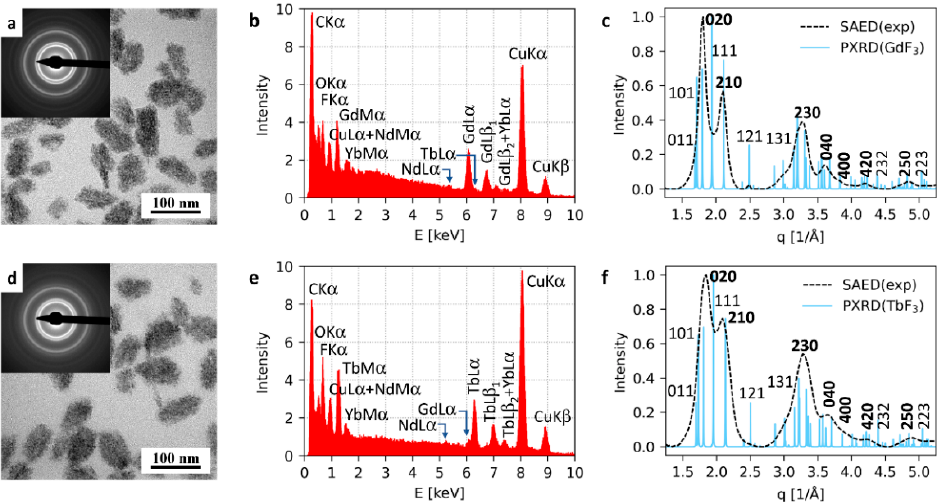
Figure 4. Characterization of P(DMA-AGME)-Ale-coated ( a – c ) GdF 3 :Tb 3+ ,Yb 3+ ,Nd 3+ and ( d – f ) TbF 3 :Gd 3+ ,Yb 3+ ,Nd 3+ nanoparticles. ( a , d ) TEM micrographs of the nanoparticles with insets showing their diffraction patterns, ( b , e ) TEM/EDX spectra, and ( c , f ) comparison of experimental selected electron diffraction patterns (TEM/SAED) with calculated powder X-ray diffraction patterns (PXRD) of orthorhombic GdF 3 and TbF 3 structures; the hk 0 diffractions, which were stronger in TEM/SAED than in PXRD due to preferred orientation of nanocrystals, are marked with bold